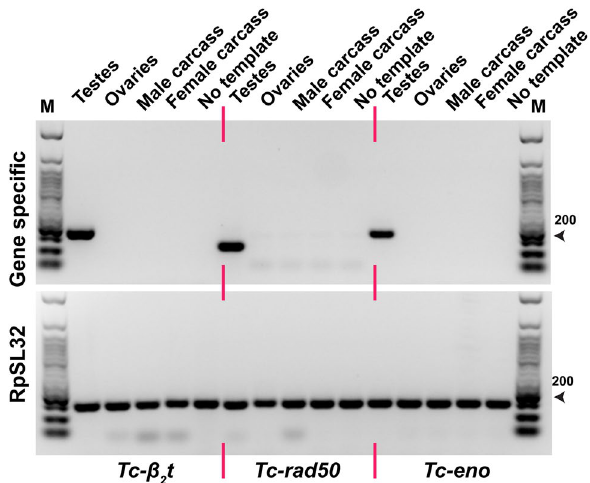
Figure 1. Tc-β 2 t , Tc-rad50 and Tc-eno are expressed specifically in the testes of T. castaneum . RT-PCR-based transcript analysis of cDNA prepared from white-eye mutant T. castaneum adults. T. castaneum